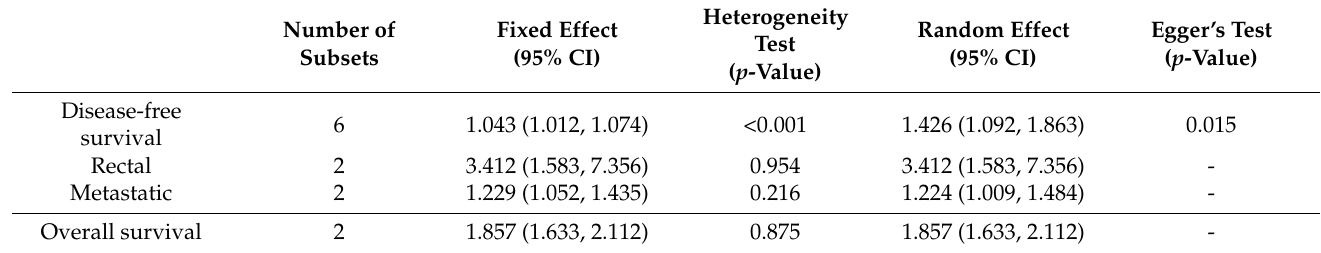
Table 5. The prognostic implications of intratumoral budding in colorectal